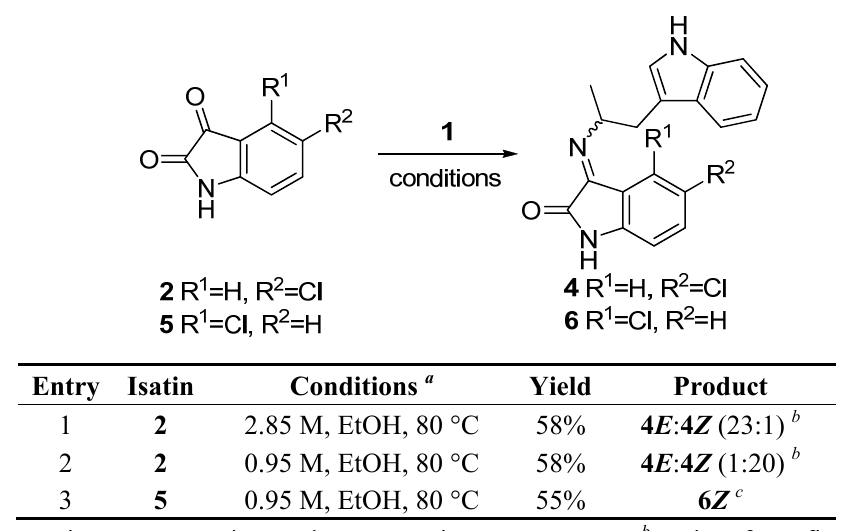
Table 1. Preparation of imines